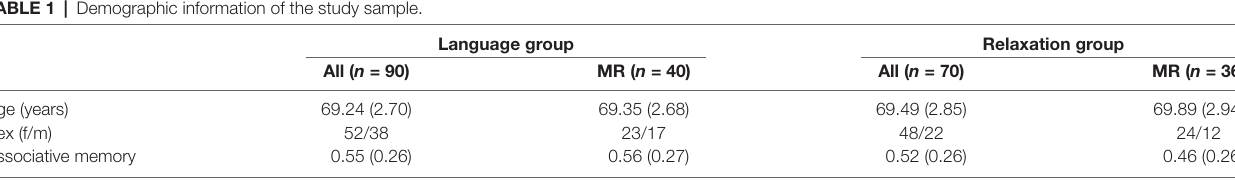
TABLE 1 | Demographic information of the study